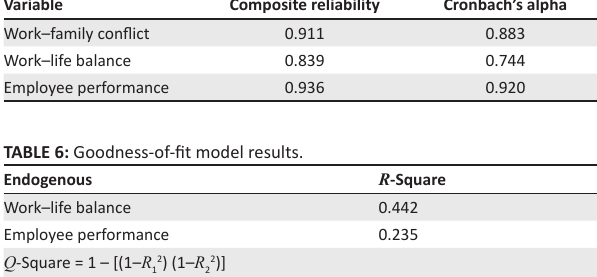
TABLE 3: Average variance extracted.